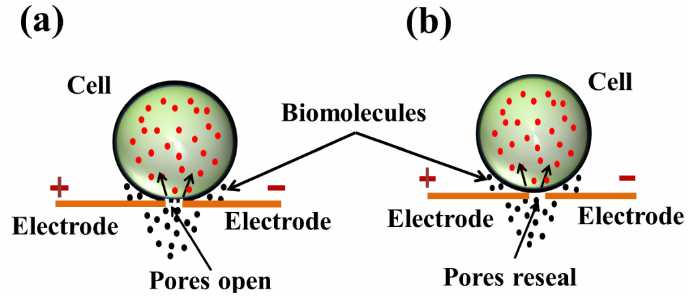
Figure 4. Localized single cell membrane electroporation (LSCMEP) where electric field is applied in a specific region (nano-scale region) of the cell membrane. ( a ) During electroporation, membrane pores open and biomolecules deliver from outside to inside of the single cell; ( b ) After electroporation cell membranes reseal again and biomolecules entered successfully inside the single cell. Permission to reprint obtained from Springer